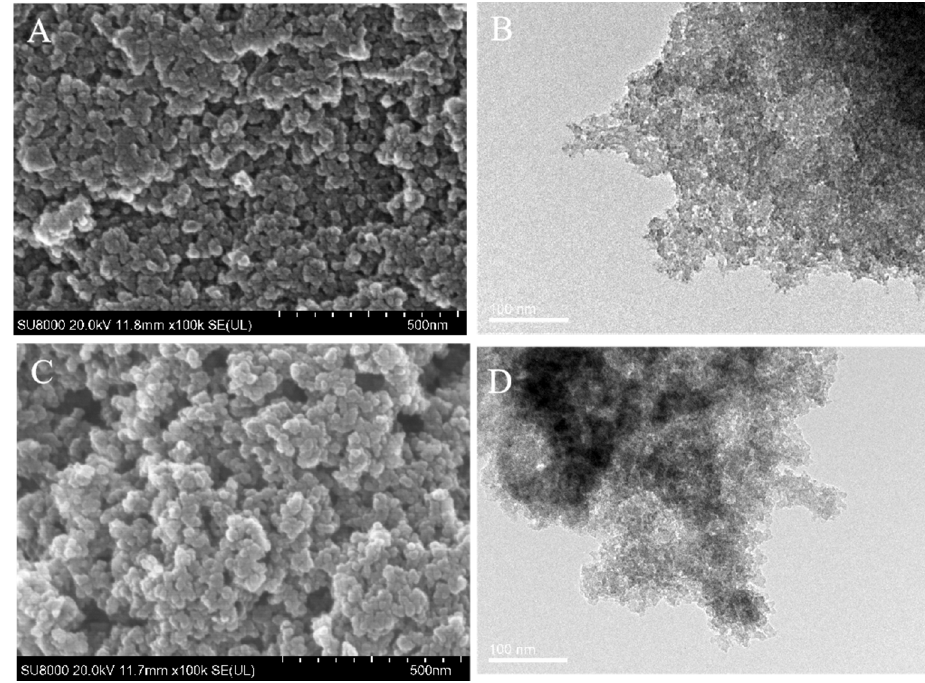
Figure 3. ( A , C ) SEM image, and ( B , D ) TEM image of ( A , B ) POP-PBC and ( C , D ) POP-PBH.